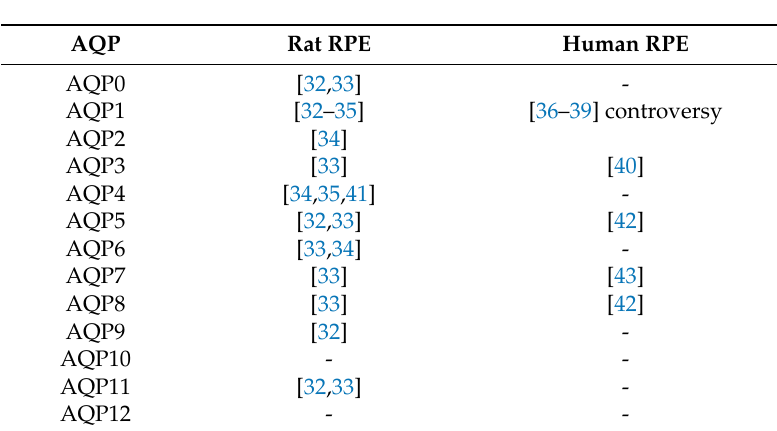
Table 2. AQP expression in RPE